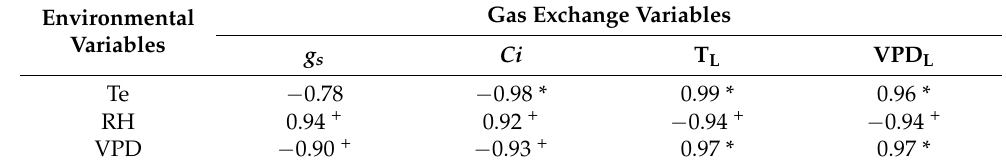
Table 2. Correlation of environmental variables (temperature—Te, relative humidity—RH, air va- por pressure deficit—VPD) with gas exchange variables (stomatal conductance— g s , internal CO 2 concentration— C i , leaf temperature—T L , vapor pressure deficit between the leaf and the air of the IRGA chamber—VPD L